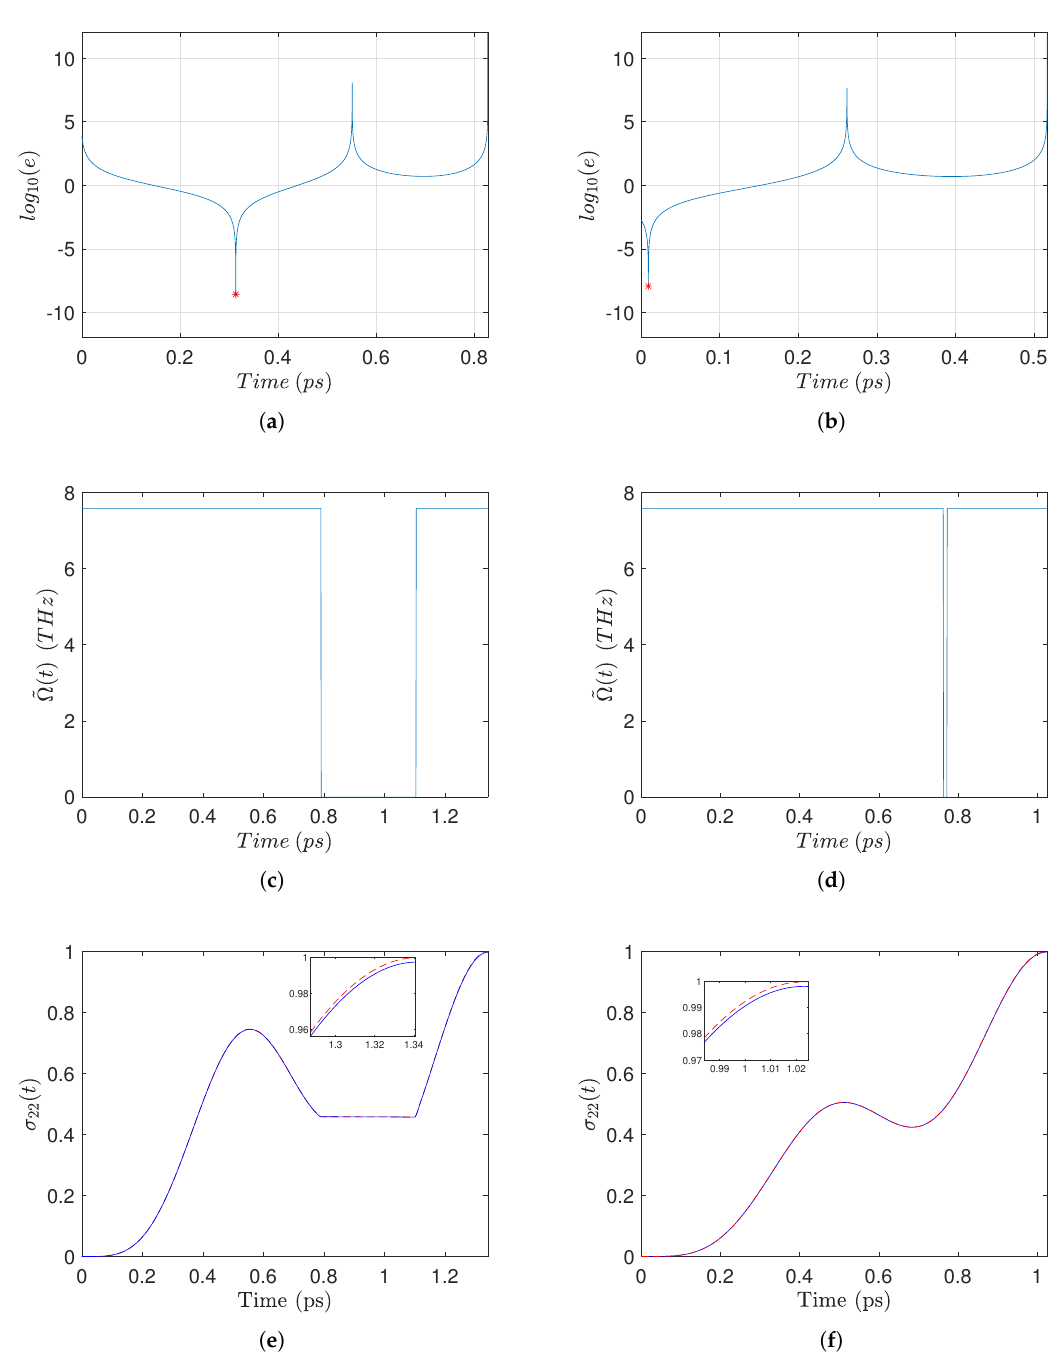
Figure 2. Left-column top to bottom: ( a ) Logarithm of the squared error between the two sides of transcendental Equation (27) as a function of the duration t 2 of the intermediate (off) pulse. The negative resonance indicated with red star corresponds to the solution. ( c ) Corresponding on-off pulse-sequence. ( e ) Time evolution of biexciton population σ 22 ( t ) (blue solid line) obtained by simulating the full Equation (6) with input the above pulse-sequence. For comparison, the red dashed line shows σ 22 ( t ) if relaxation is ignored from the system equations. These results are obtained for interparti- cle distance R = 14 nm and biexciton energy shift E B = 5 meV. In the right-column ( b , d , f ) we display similar plots for the case with the same R = 14 nm but larger E B = 8